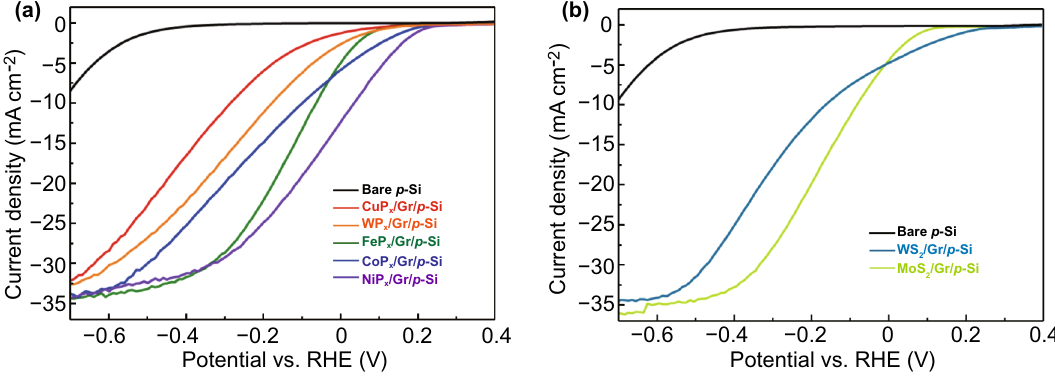
Fig. 7 a Polarization ( J ‑ V ) curves of copper phosphide, tungsten phosphide, iron phosphide, cobalt phosphide, and nickel phosphide deposited photocathodes. b Polarization ( J ‑ V ) curves of tungsten disulfide and molybdenum disulfide deposited